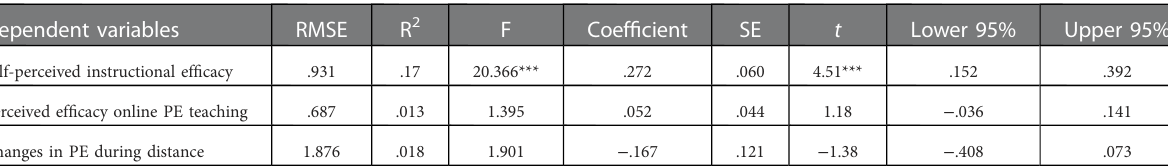
TABLE 5 Multivariate regression analyses testing the in fl uence of incremental beliefs on self-perceived instructional ef fi cacy, perceived ef fi cacy of delivering online PE teaching, and changes in PE during distance learning ( n